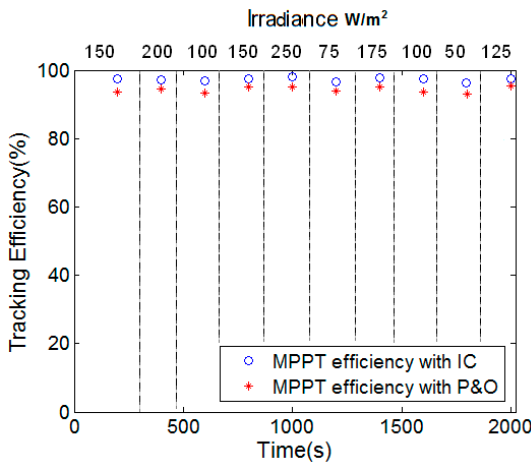
Figure 16. MPPT efficiency comparison.